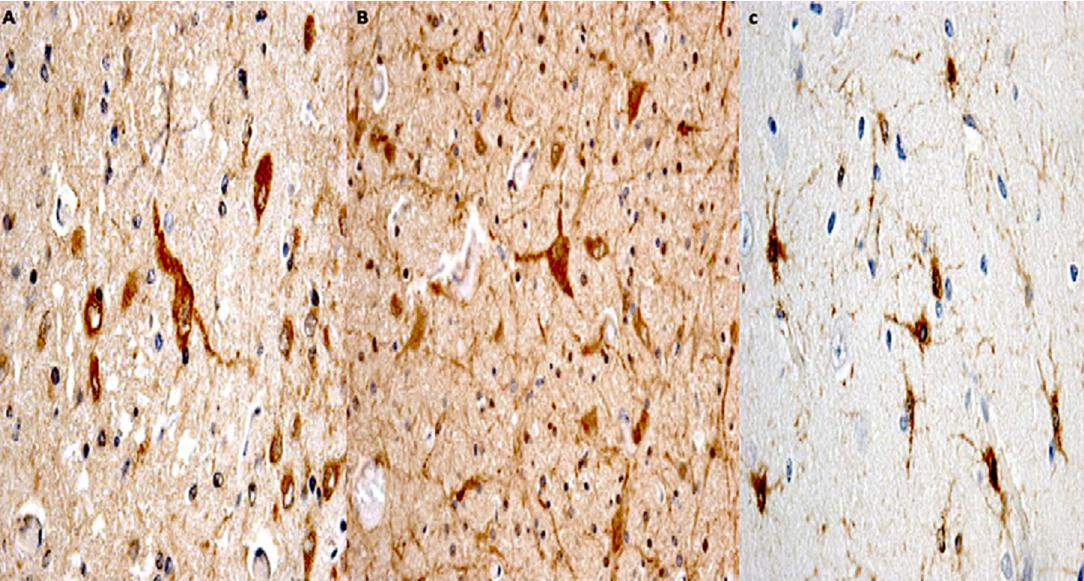
Figure 8. ( A ) A significant increase in GFAP immunopositivity (brown reactions) was observed in group 4: swollen astrocytes and neurons remained evident for all the regions assessed (magnification 200×). ( B , C ) Group 6: an increasing in reactive astrocytes was detected (magnification 150×); at high magnification astrocytes became visibly larger with increased soma sizes and thickened processes (magnification 200×).